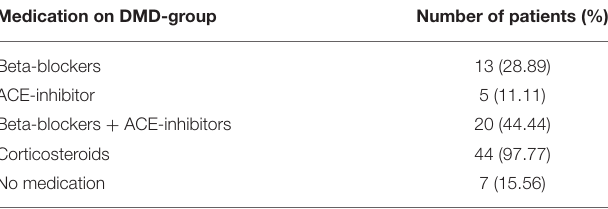
TABLE 3 | The cardiac medications for DMD-group. Medication on DMD-group Number of patients (%)